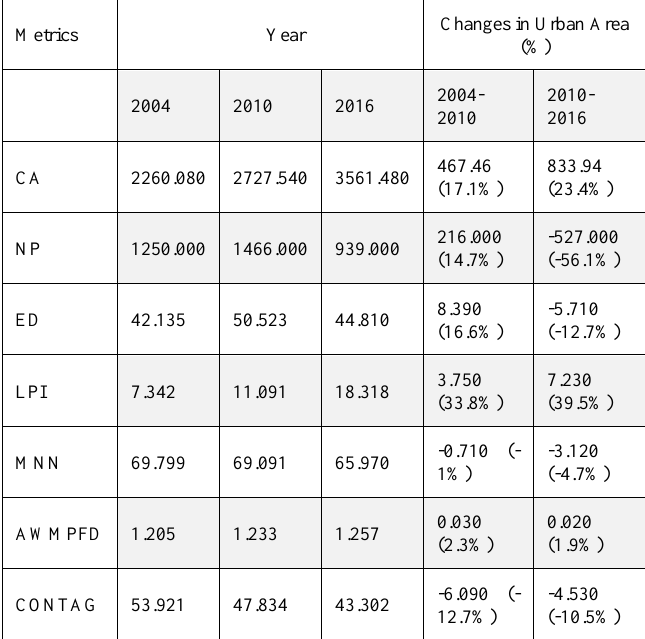
Table 2. Spatial metrics and their changes in the study area